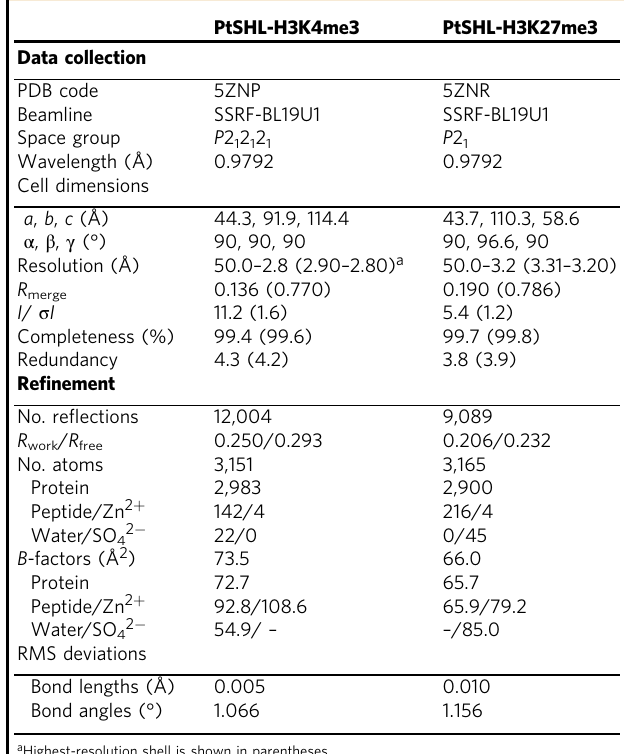
Table 1 Data collection and re fi nement statistics